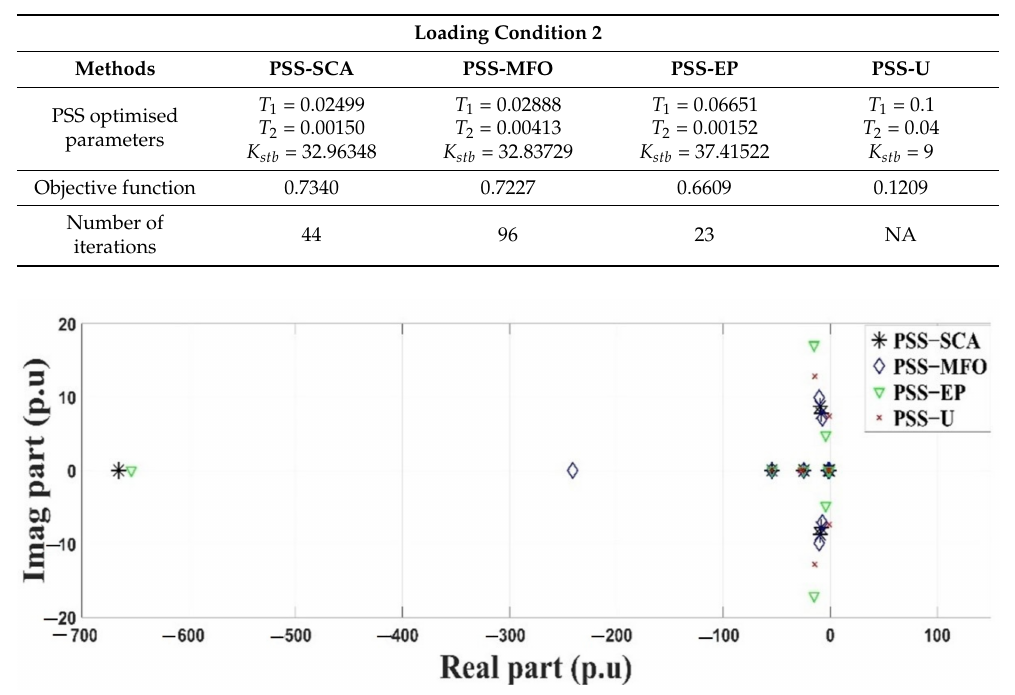
Table 8. Comparison of the PSS optimised parameters, eigenvalues and damping ratio for loading condition 2 of the SMIB.